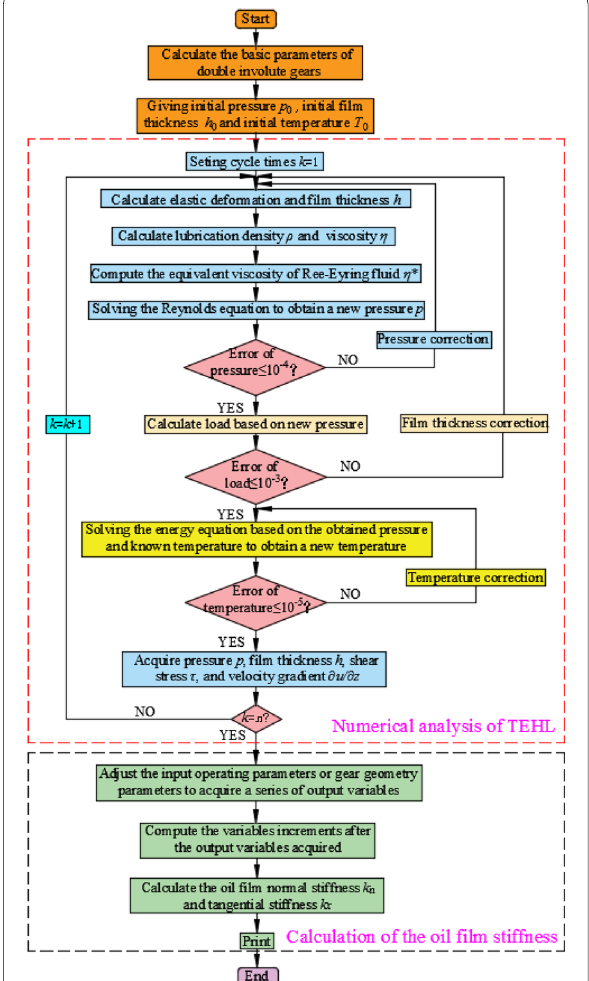
Figure 7 Flow chart of the calculation